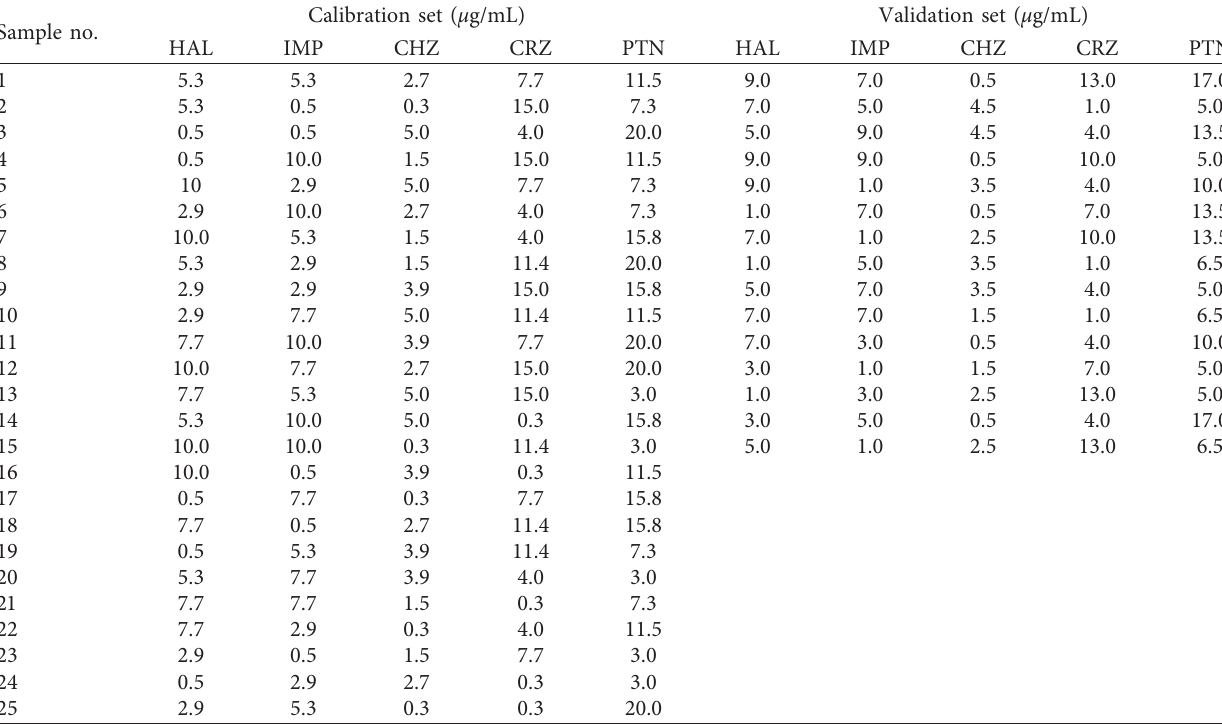
Table 1: The concentration matrix used for the preparation of the calibration and validation sets of CHZ, CRZ, HAL, IMP, and PTN. Sample